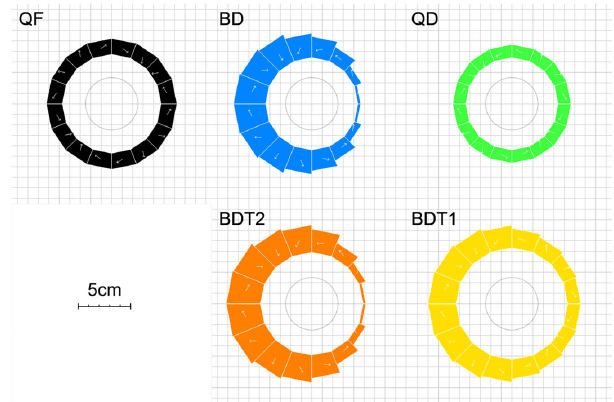
FIG. 1. Permanent magnet cross sections with 1 cm grid.